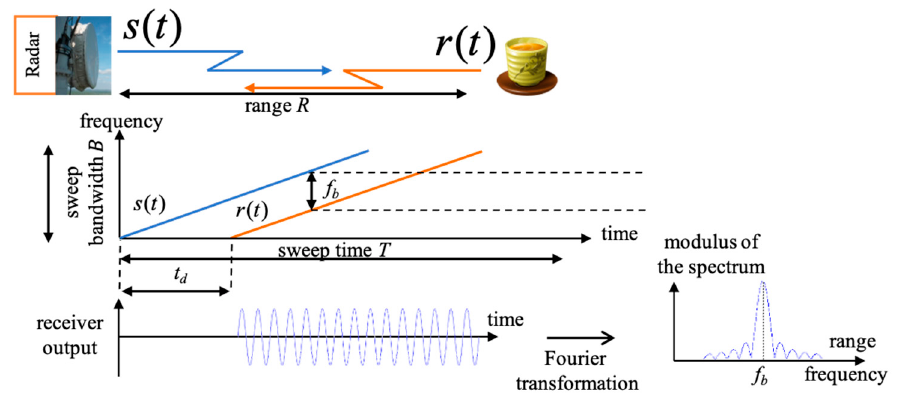
Figure 3. FMCW basic